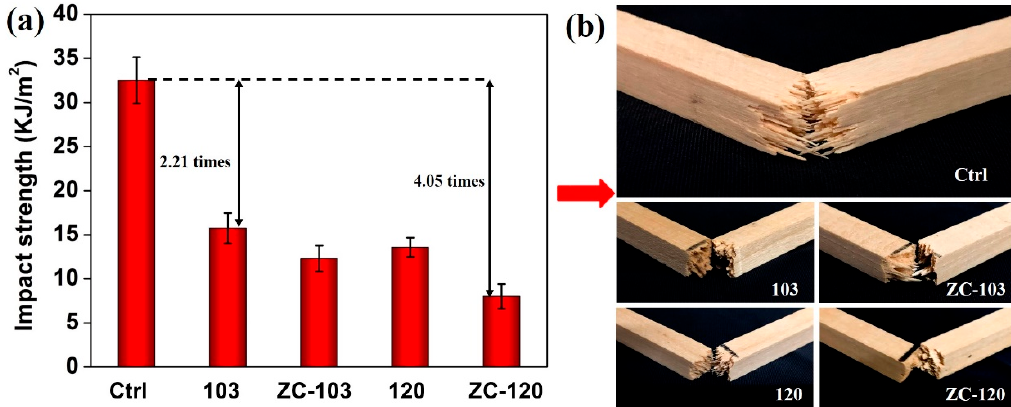
Figure 9. The impact strength of the wood samples after the four treatments 103, ZC-103, 120, and ZC-120 ( a ); fracture surfaces of the samples after the impact test ( b ).